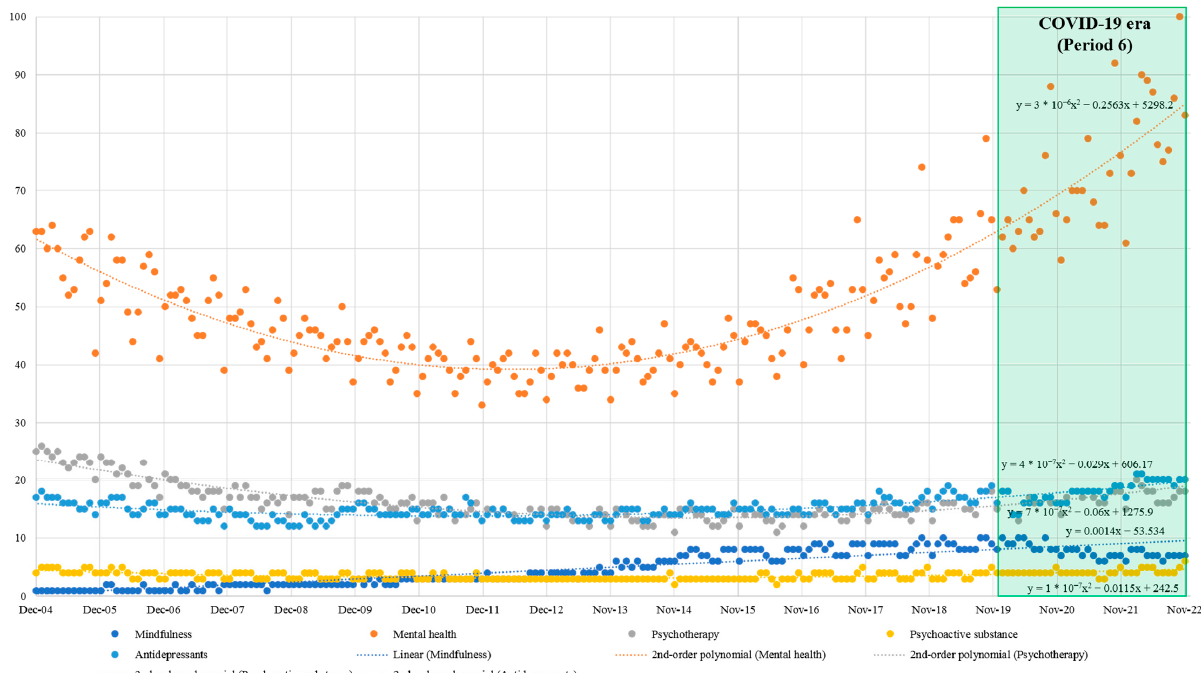
Figure 1. Relative search volume of ‘Mindfulness’, ‘Mental health’, ‘Psychotherapy’, ‘Psychoactive substance’, and ‘Antidepressants’ (2004 to 2022, monthly) in Google Trends. Note. The y-axis represents the relative search score and is distributed between 0 and 100 points. The x-axis represents the period.